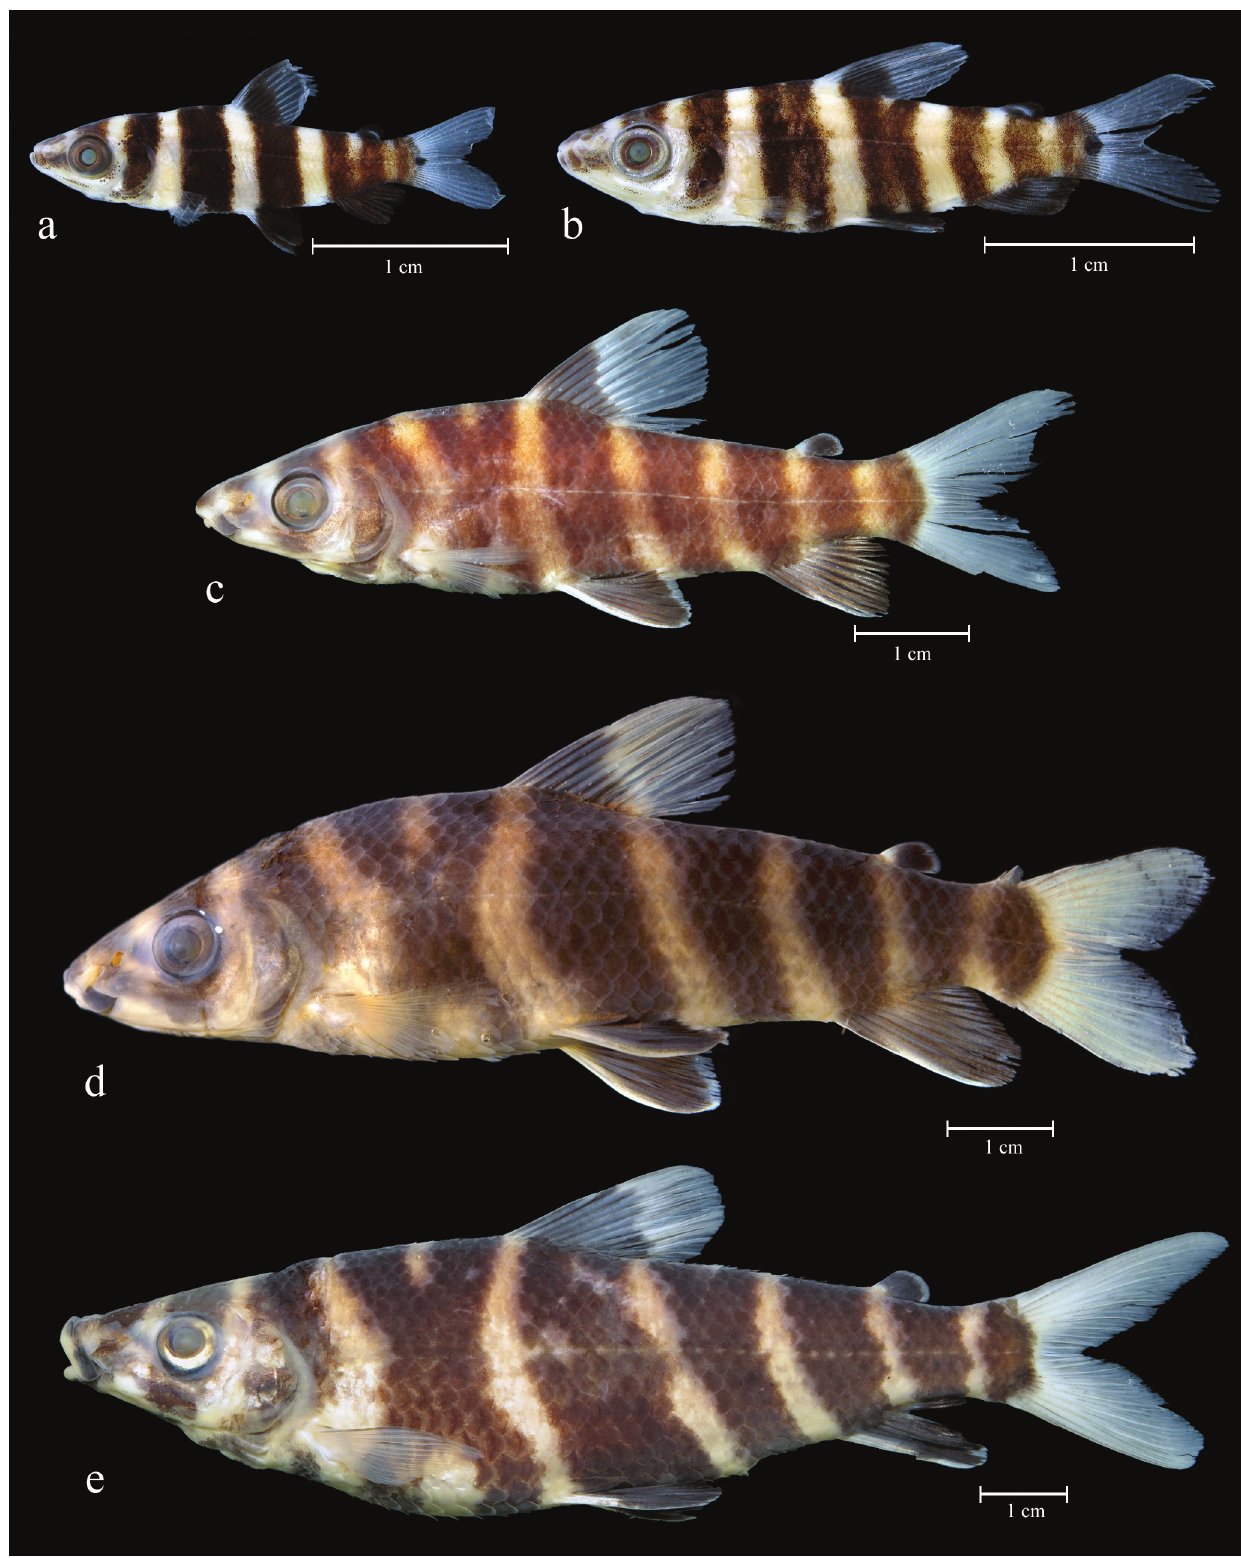
Fig. 2. Alcohol-preserved specimens of Leporinus villasboasorum : (a) paratype, MZUSP 100071, 19.5 mm SL, rio Teles Pires, Tapajós basin in Brazil, (b) paratype, MZUSP 100071, 24.9 mm SL, rio Teles Pires, Tapajós basin in Brazil, (c) paratype, MZUSP 91895, 62.0 mm SL, rio Culuene, Xingu basin in Brazil, (d) holotype, MZUSP 116530, 91.0 mm SL, rio Culuene, Xingu basin in Brazil, (e) MZUEL 7916, 109.5 mm SL, Juruena river, Tapajós basin in